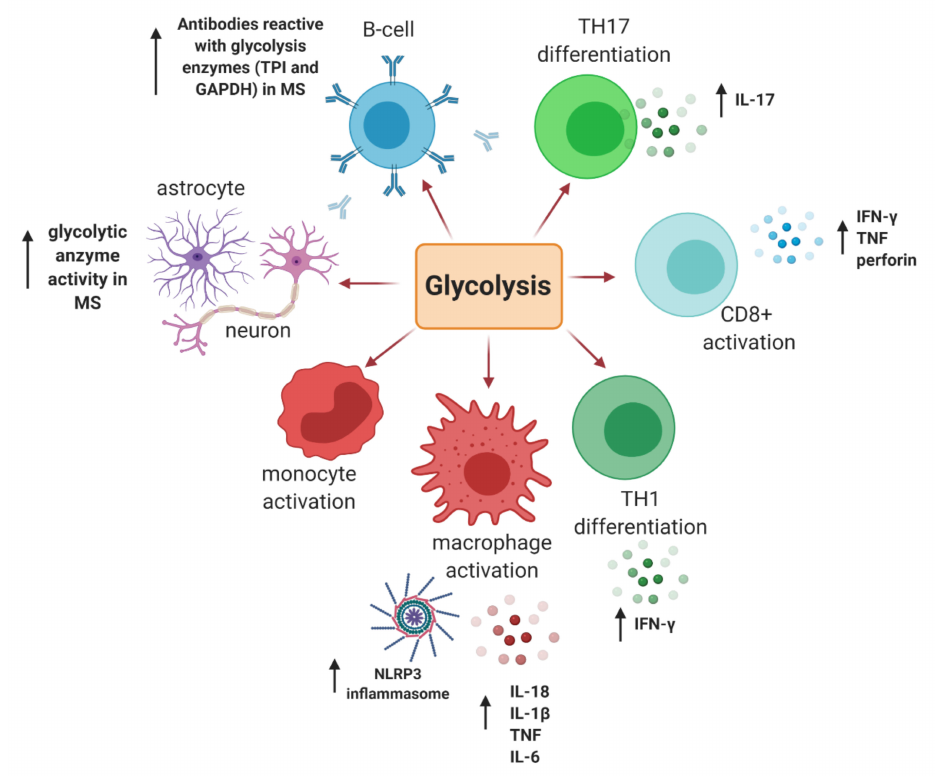
Figure 3. A summary of the impact glycolysis has on cells in MS: Glycolysis is a major pathway via which glucose is metabolised and generally is involved in activation of various immune cell subsets that are pathological in MS. Activation of immune cells such as in monocytes, macrophages and CD8 + T cells, and di ff erentiation of CD4 + T-cell subsets, such as T H 1 and T H 17, leads to production of pro-inflammatory cytokines and cytotoxic granules. IL: Interleukin; TNF: Tumor Necrosis